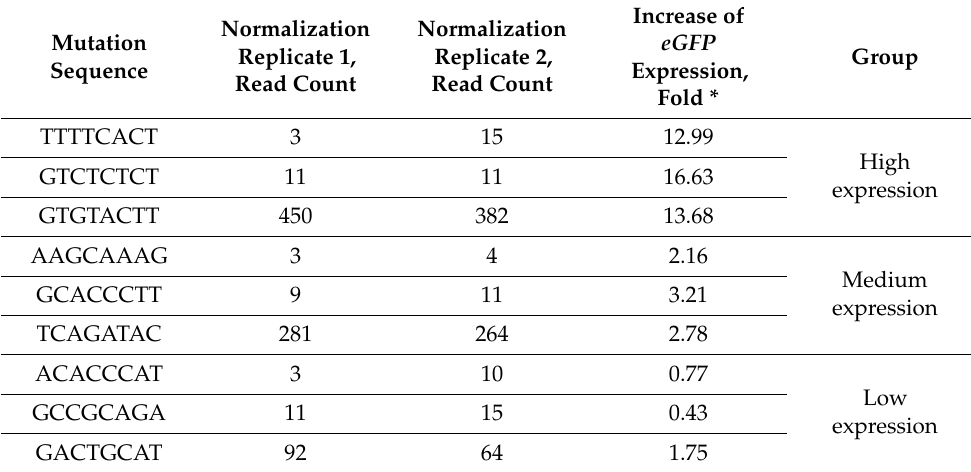
Table 3. Mutations from the MPRA library +29..+36 selected for individual tests.